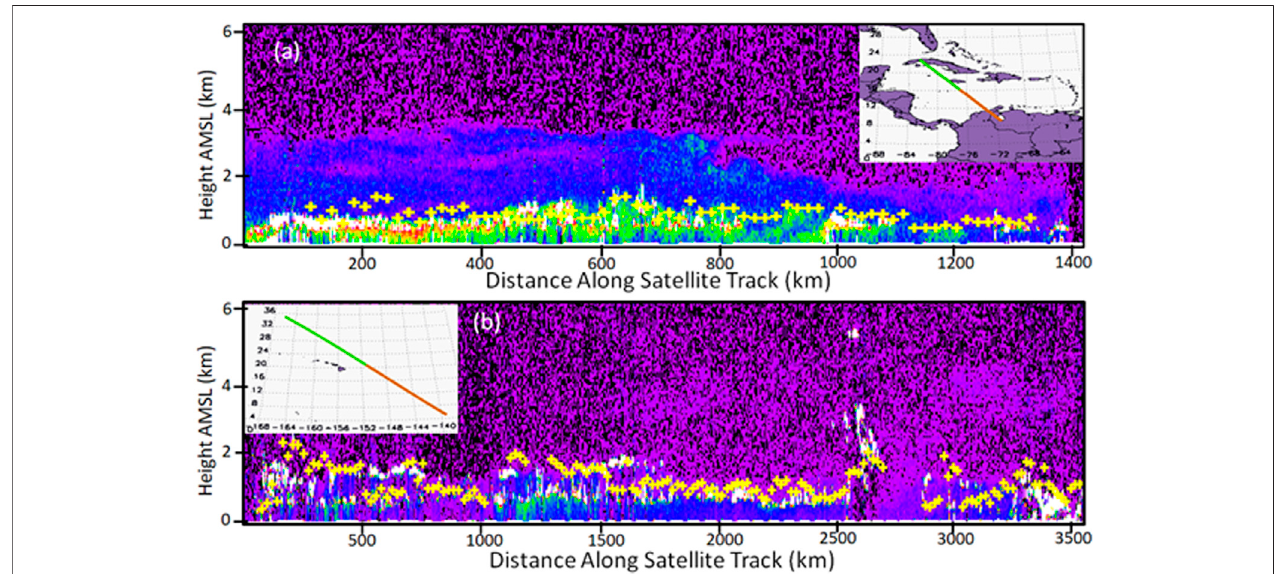
FIGURE 5| (A) CATS calibrated 1,064 nm backscatter data over the south Caribbean Sea on June 1, 2017 showing amarine PBL embedded in a thicker aerosol layer. (B) CATScalibrated1,064 nmbackscatter foratransectoverthePaci fi cOceanpassingjusteastofHawaiionJune1,2017.ThecoarsePBLtopasretrievedfrom the threshold algorithm is indicated by the yellow plus signs on both images.